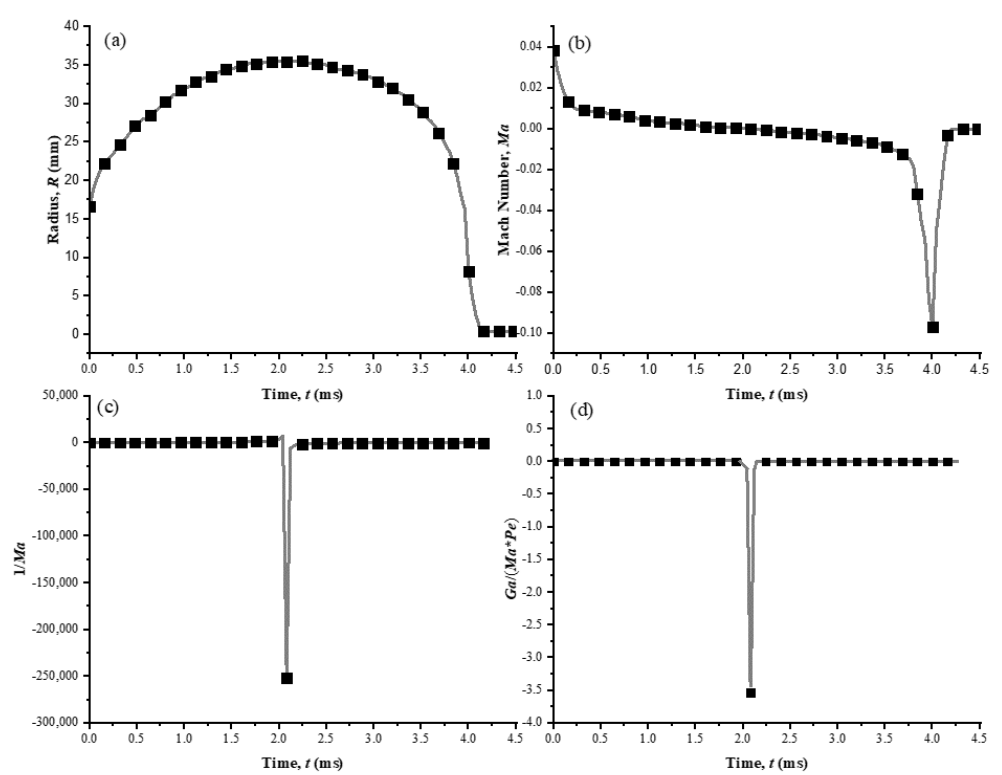
Figure 3. The companions of ( a ) R , ( b ) Ma , ( c ) 1 / Ma , and ( d ) Ga / ( Ma * Pe ) for the case of bubble dynamics near the rigid boundary, where R is the instantaneous radius of the bubble; Ma is the Mach number; Pe the Peclet number; and Ga the Gay-Lussac number [37].